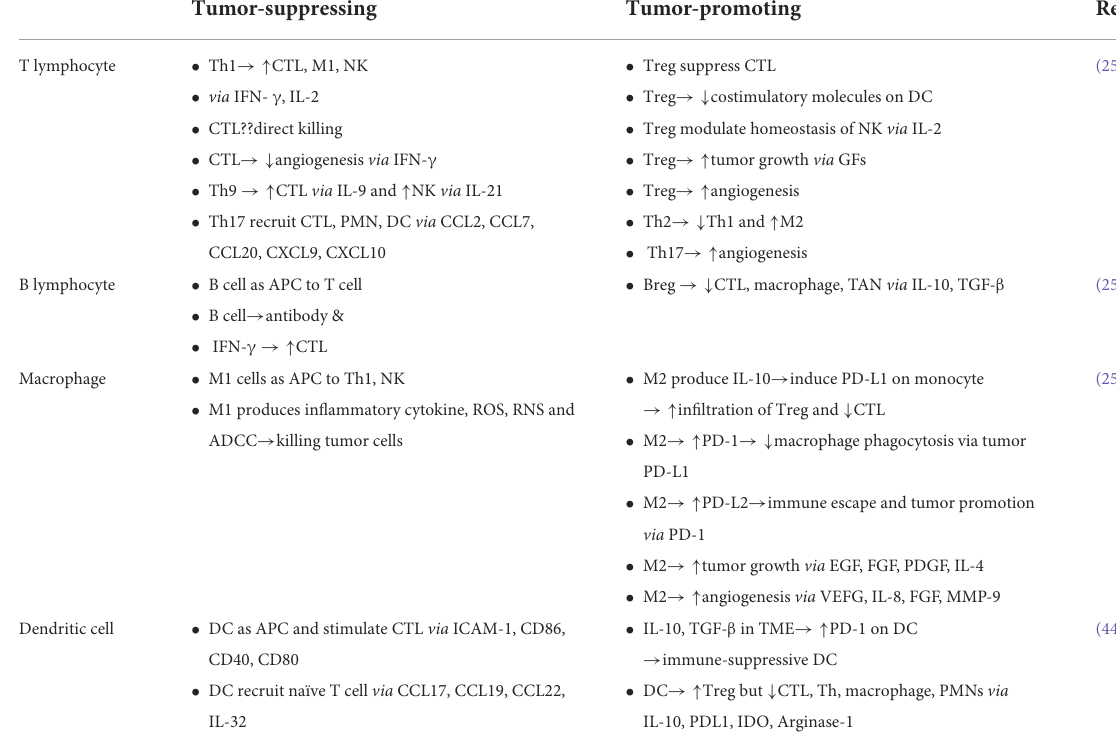
TABLE 1 Tumor-suppressing and tumor-promoting roles of diverse cells in tumor microenvironment. Tumor-suppressing